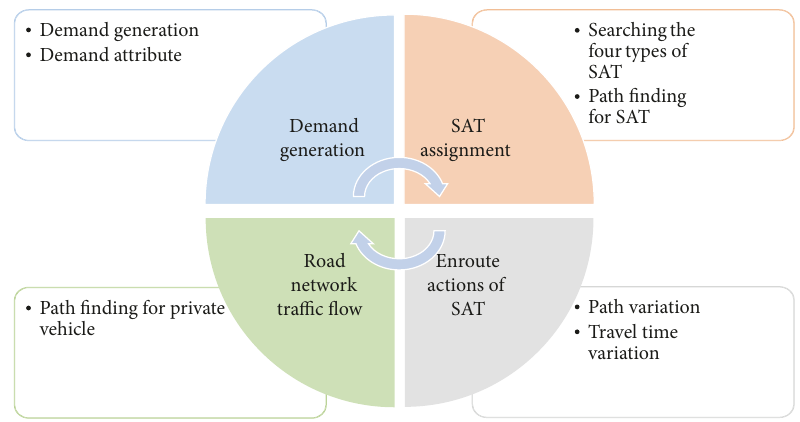
Figure 1: Shared autonomous taxi system (SATS) integrated into traffic